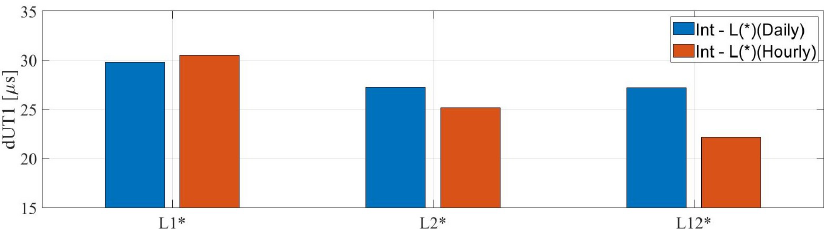
Figure 9. The root mean square values of the differences between daily and hourly dUT1 from the IVS-Int and the 24 h sessions (L1, L2, and L12 networks), represented by blue and red,